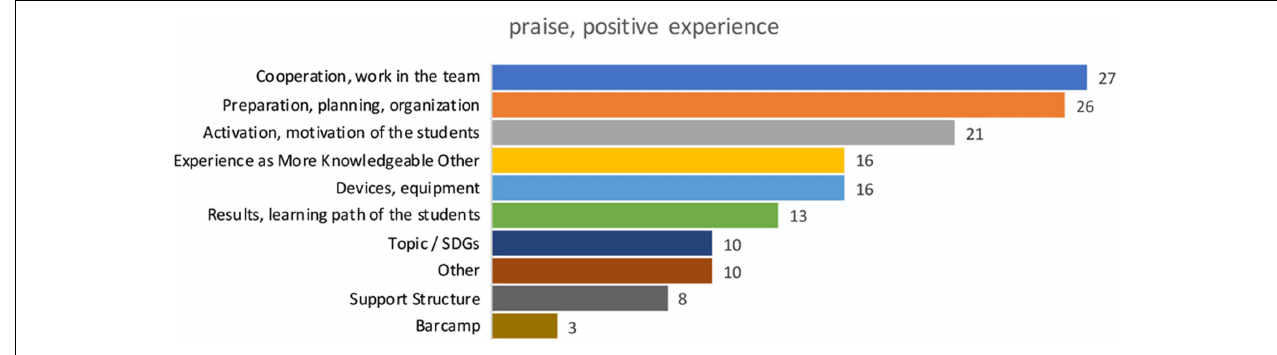
FIGURE 3 | Frequencies of interviews with mentions of the listed categories regarding praise and positive experiences in the project.